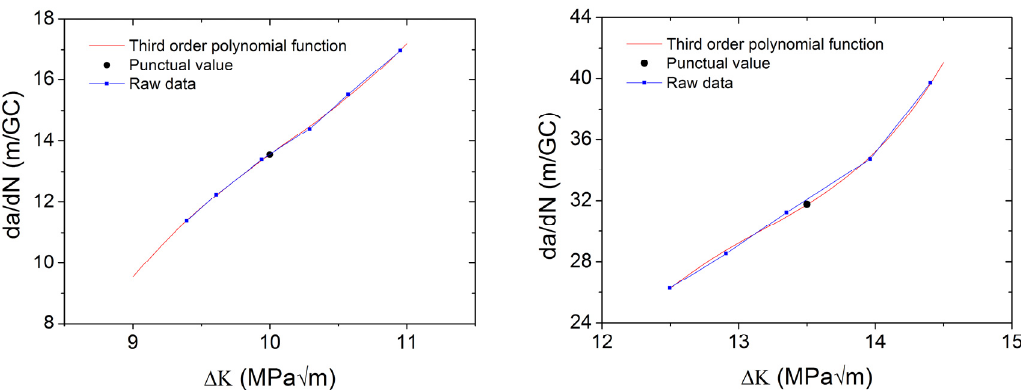
Figure 9: Third order polynomial fit of the crack growth rates.